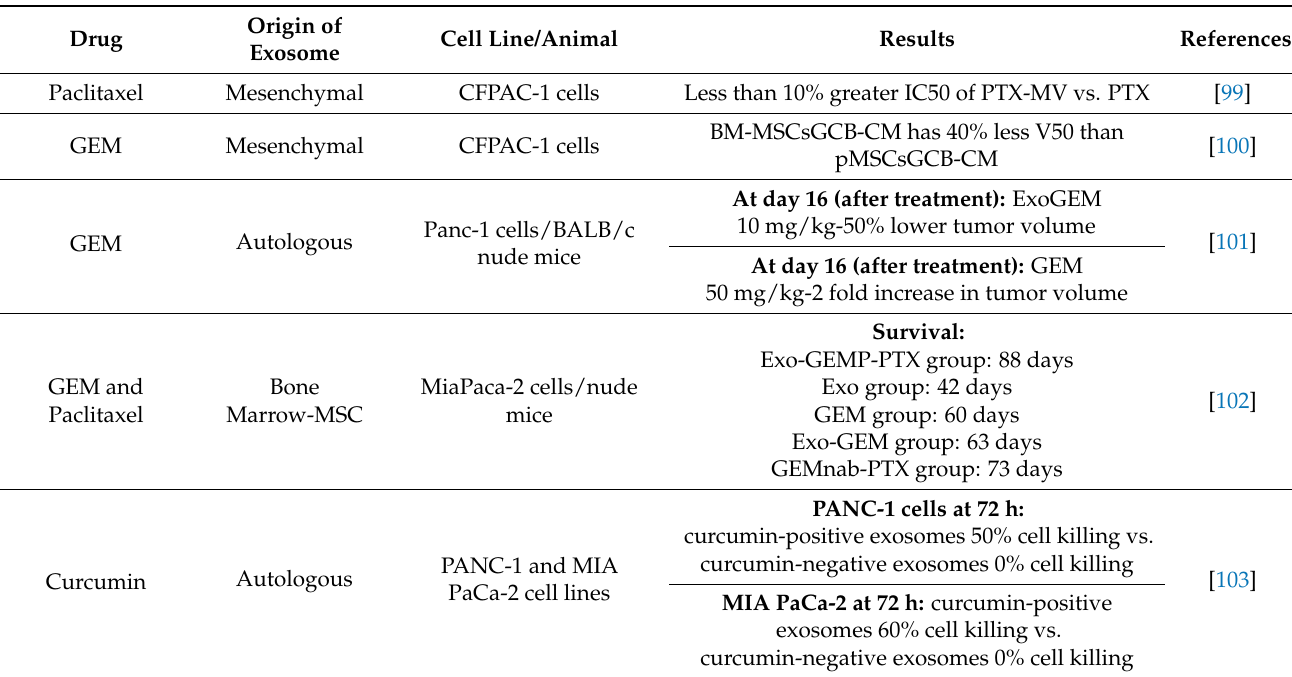
Table 1. The effects of chemotherapeutics utilized against PDAC in in vivo and in vitro experiments.